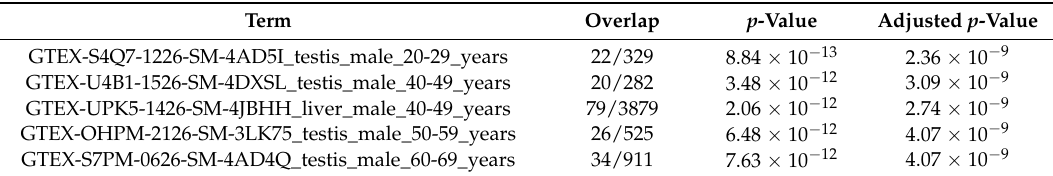
Table 10. Top ranked five gene expression profiles in “GTEx Tissue Sample Gene Expression Profiles down” whose altered genes are associated with 244 gene